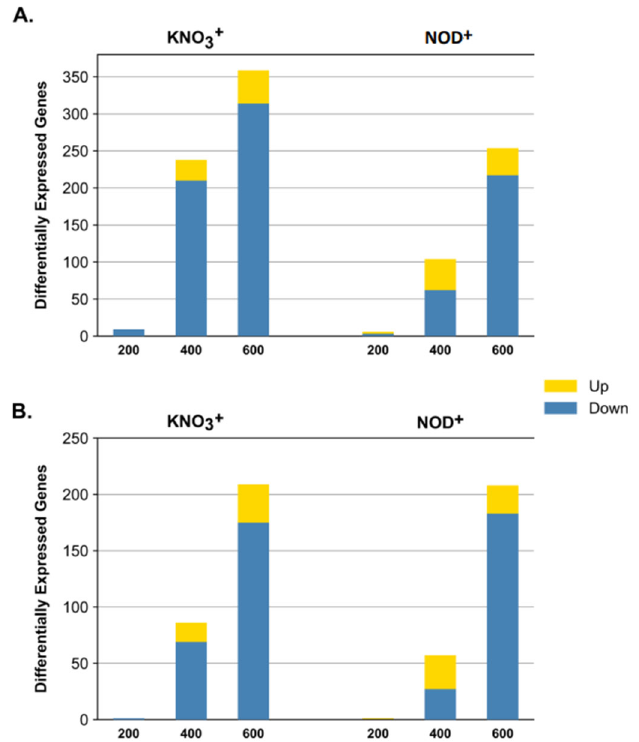
Figure 1. Differential gene expression in branchlets of Casuarina glauca plants nodulated by nitrogen ‐ fixing Frankia casuarinae Thr (NOD + ) or supplied with KNO 3 (KNO 3+ ). 200: 200 vs. 0 mM NaCl; 400: 400 vs. 0 mM NaCl; and 600: 600 vs. 0 mM NaCl, with a False Discovery Rate < 0.05. ( A ) Total number of DEGs. ( B ) Number of DEGs specific to each salinity condition relative to control. Table 1. Differential gene expression quantification in branchlets of Casuarina glauca nodulated by nitrogen ‐ fixing Frankia casuarinae Thr (NOD + ) or non ‐ nodulated plants supplied with KNO 3 (KNO 3+ ), grown at control (0 mM NaCl) and three salinity conditions (200 mM, 400 mM and 600 mM NaCl). Number of total expressed genes by each plant, at each condition, number of genes expressed by both treatment and control of each comparison (common genes percentage relative to the respective average gene expression between brackets), number of differential expressed genes (DEGs) detected by DESeq, NOISeq and edgeR analyses, number of overlapping DEGs in the three analyses (DEGs percentages relative to the respective average gene expression between brackets) and number of respective annotated DEGs, enumerated by type of regulation. Detected and over ‐ lapping DEGs correspond to the number of significant DEGs in each salinity ‐ stress treatment in comparison with the control NaCl (respectively, 200: 200 mM vs. 0 mM, 400: 400 mM vs. 0 mM and 600: 600 mM vs. 0 mM), with a False Discovery Rate < 0.05 and a normalized log2 fold change (log2FC) > 2 or < − 2.